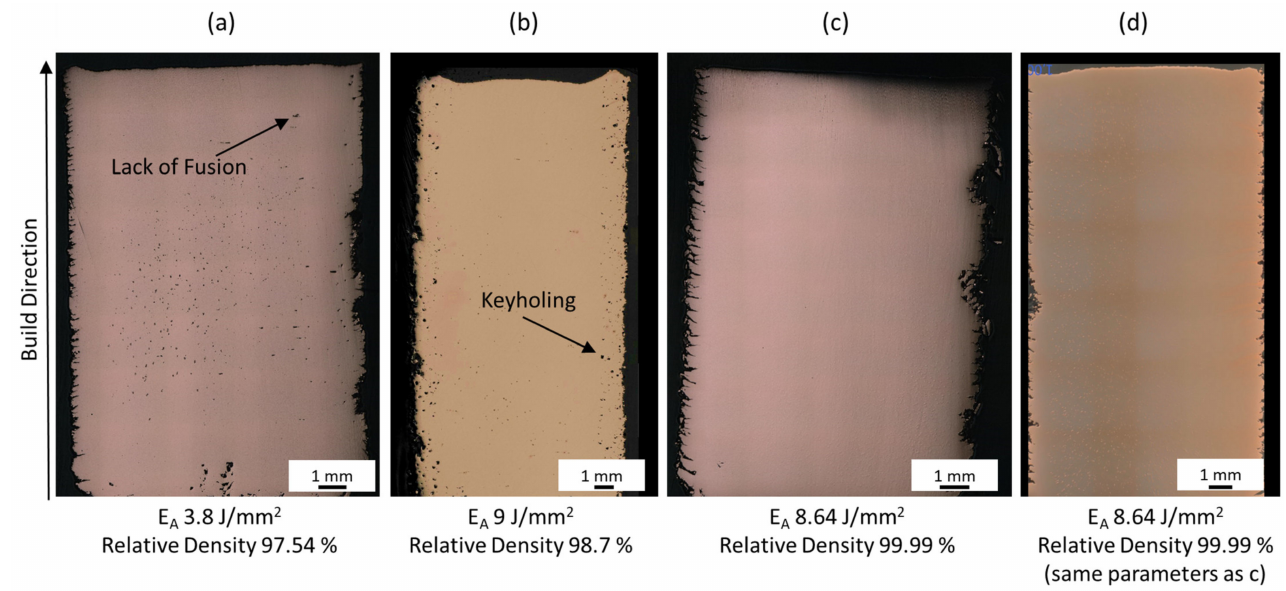
Figure 2. ( a ) Cube with Lack of Fusion; ( b ) Cube with Keyholing; ( c ) Cube with relative density of 99.99%; ( d ) Cube with the same parameters as in ( c ) to verify